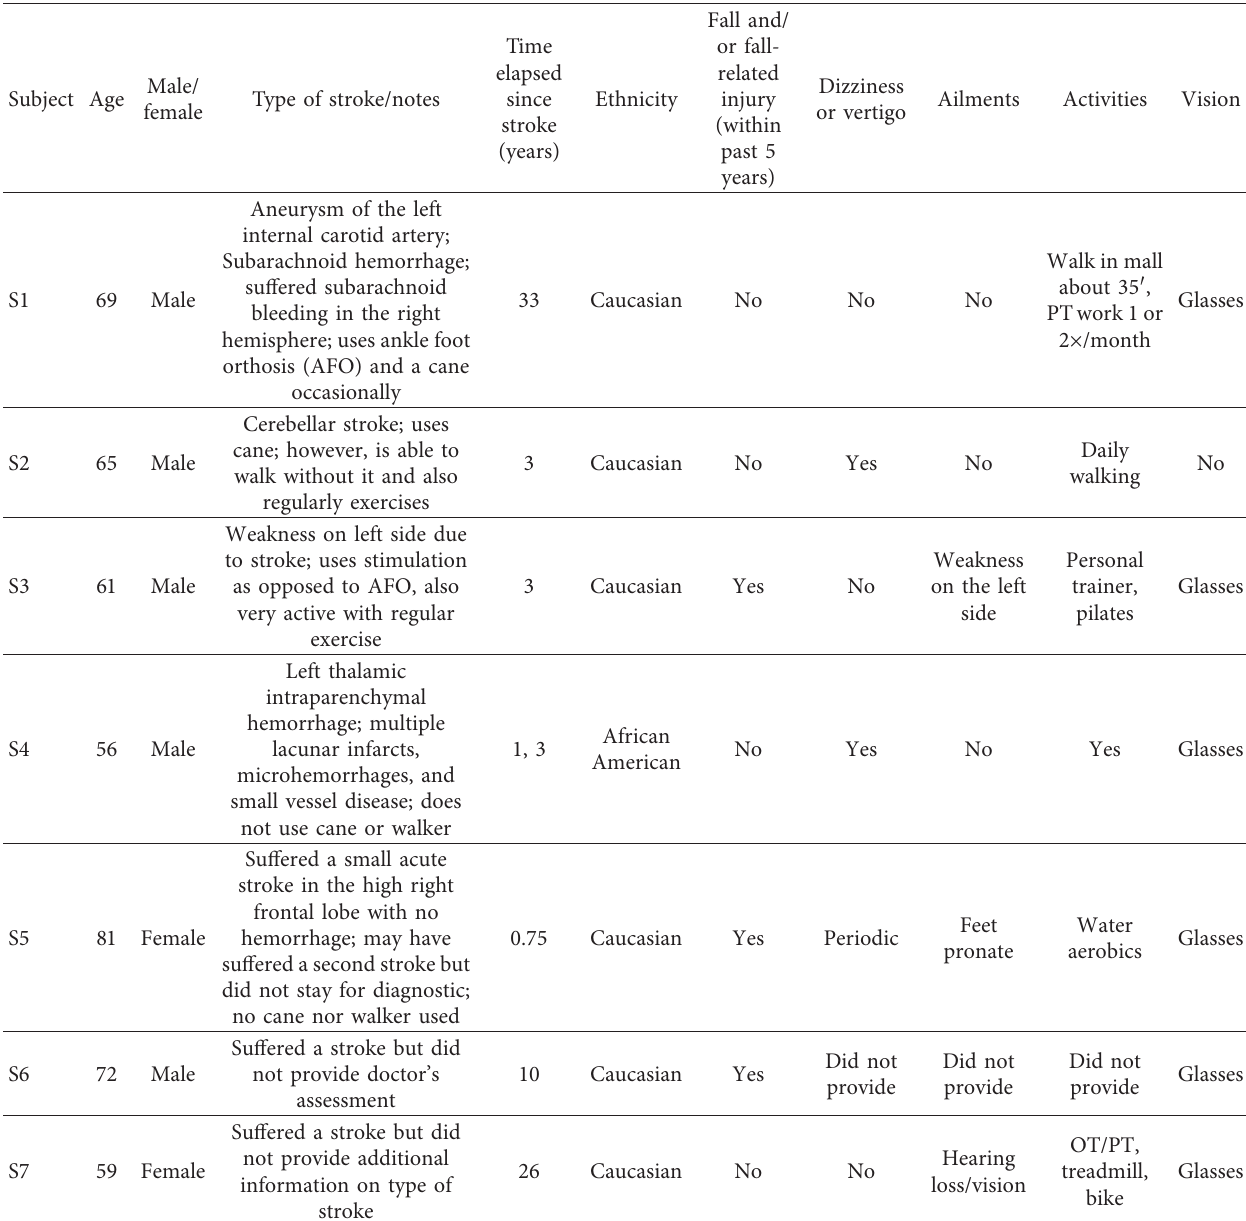
Table 1: Demographics of survivors of